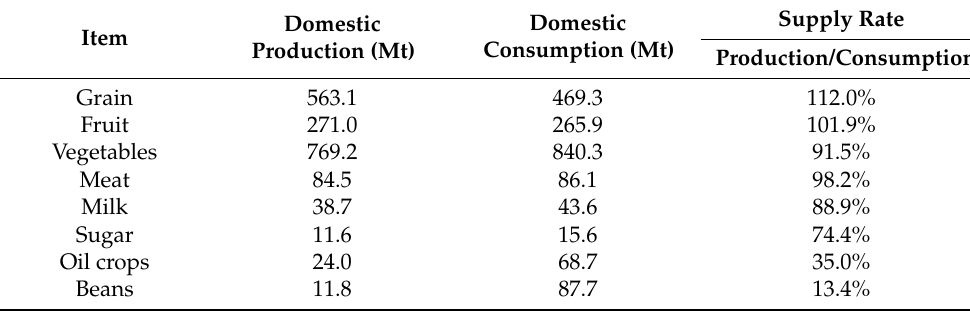
Table 1. China’s supply and demand of major agricultural products in